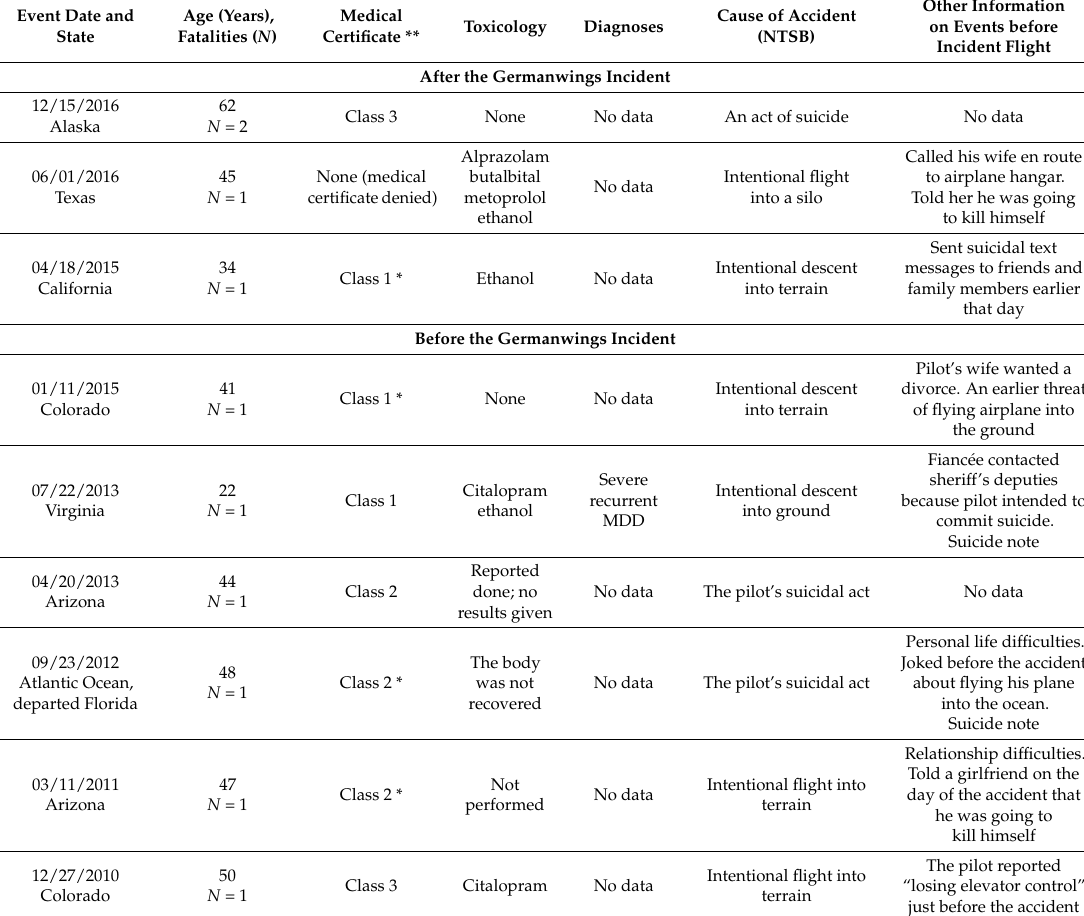
Table 1. Aircraft-assisted suicides (all males) in the National Transportation Safety Board (NTSB) database five years before and two years after the Germanwings flight into the French Alps on 24 March